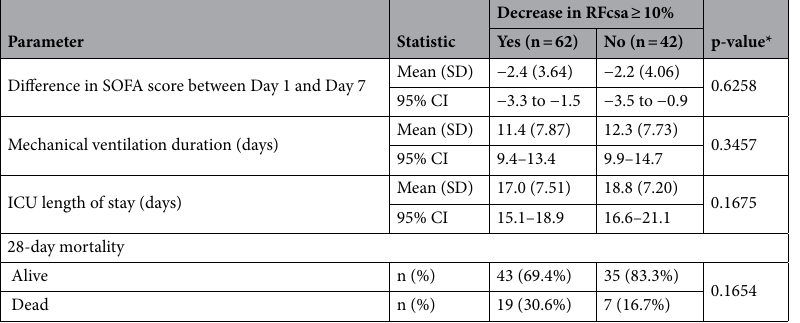
Table 3. Outcome characteristics of patients. SOFA sequential organ failure assessment. *p-value of Wilcoxon–Mann–Whitney U-test for continuous parameters and Fisher’s exact test for mortality.